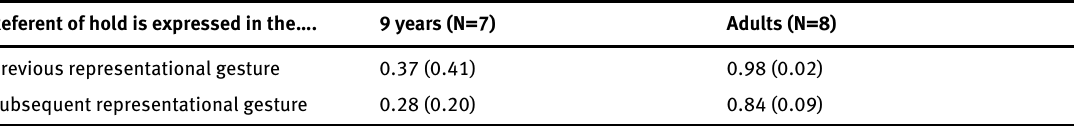
Table 5. The proportion (and the standard deviation) of the gestures with a single-handed stroke and a simultaneous hold in which the referent of the hold was represented in any previous or subsequent representational gesture. Referent of hold is expressed in